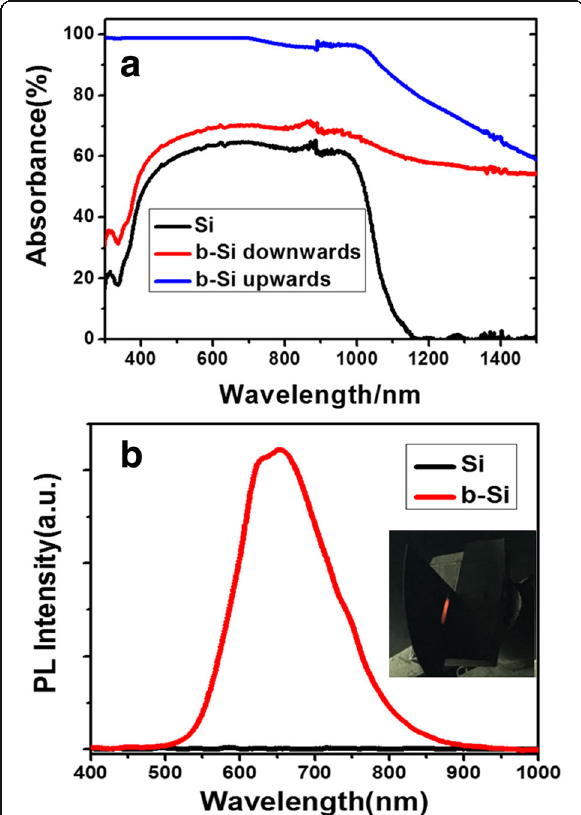
Fig. 3 Absorption spectra of a wafer Si, b-Si that faces the incident light, and b-Si with its back toward the incident light ( a ). PL of Si and b-Si under illumination of a 325-nm exciting laser ( b ). The inset shows the b-Si under illumination of the 325-nm